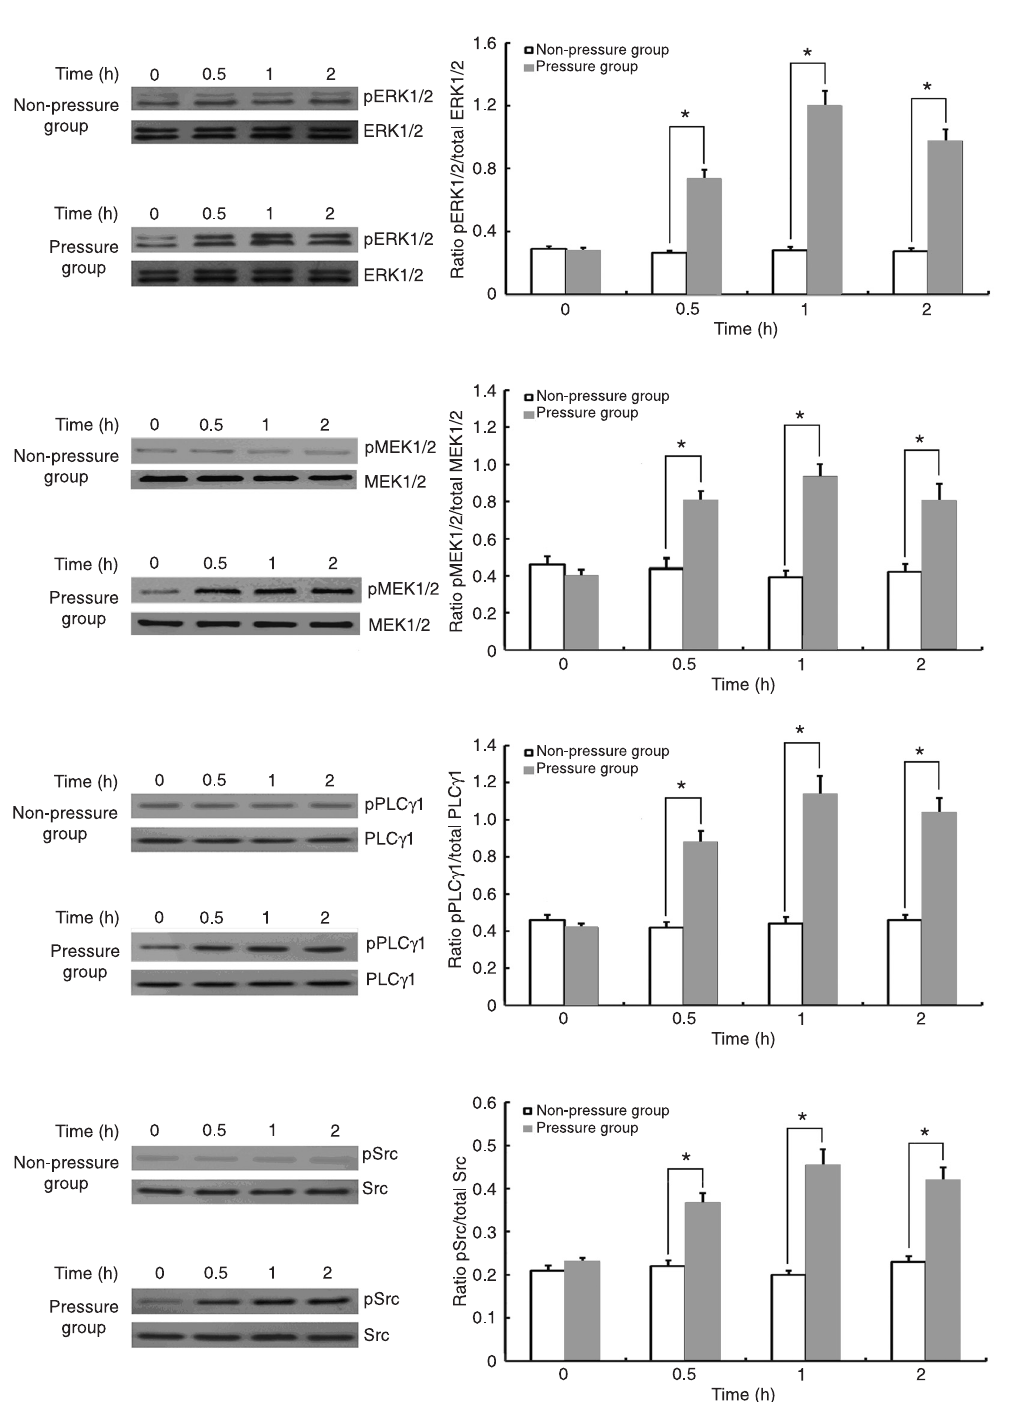
Figure 2. Effect of periodic mechanical stress on the expression and phosphorylation of ERK1/2, MEK, PLCγ1, and Src. Rat chondrocytes were cultured in vitro for 0, 0.5, 1, and 2 h, with or without periodic mechanical stress. The expression and phosphorylation level of ERK1/2, MEK, PLCγ1, and Src were detected by Western blotting, and the total quantity of each protein served as the control. The images on the left are representative of the results of West- ern blotting. The phosphorylation levels of ERK1/2-Thr 202 /Tyr 204 , MEK-Ser 217/221 , PLCγ1-Tyr 783 , and Src-Tyr 418 in the pressure group at 0.5, 1 and 2 h were significantly increased relative to those in the non-pressure group (N = 5, *P < 0.05, Student unpaired t